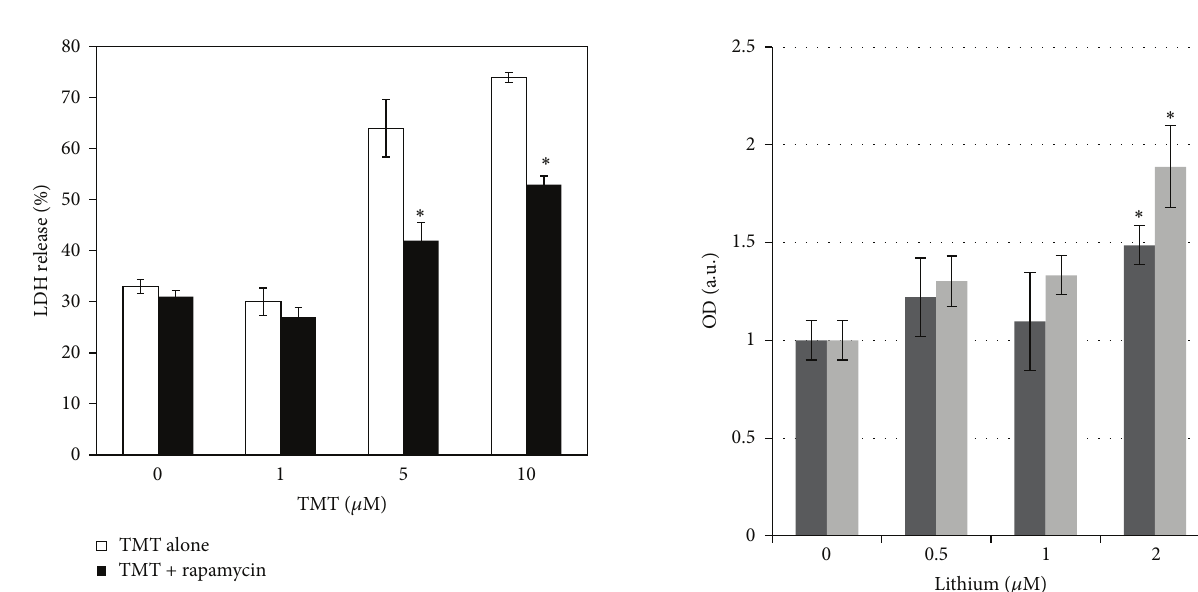
Figure 6: Rapamycin protects PC12 cultures from TMT toxicity.